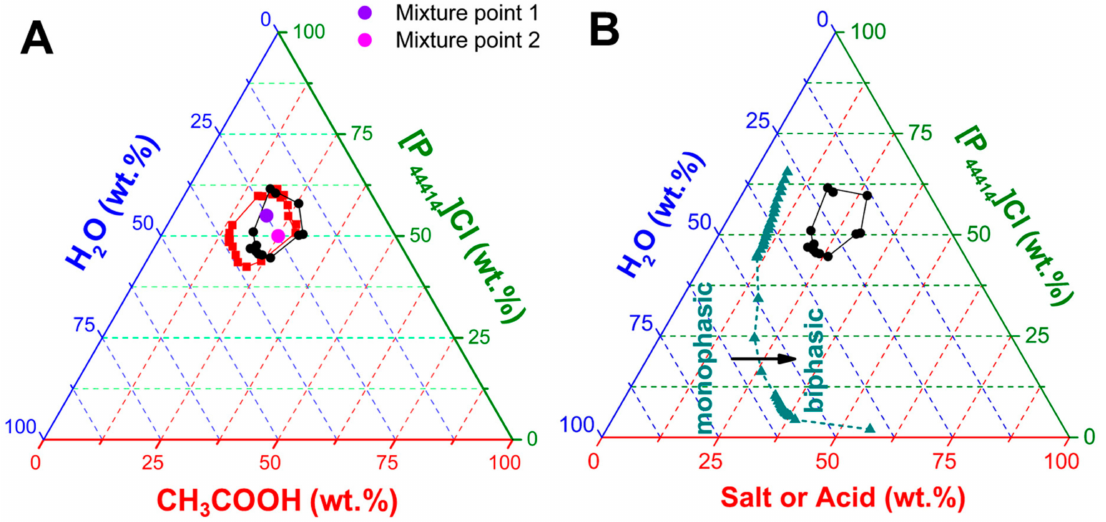
Figure 1. ( A ) Phase diagram of the [P 44414 ]Cl + CH 3 COOH + H 2 O system at 298 K ( black) and 323 K ( red). ( B ) Comparison of the experimental phase diagrams for the aqueous biphasic system composed of [P 44414 ]Cl and CH 3 COOH or NH 4 CH 3 COO ( ▲ cyan) at 298